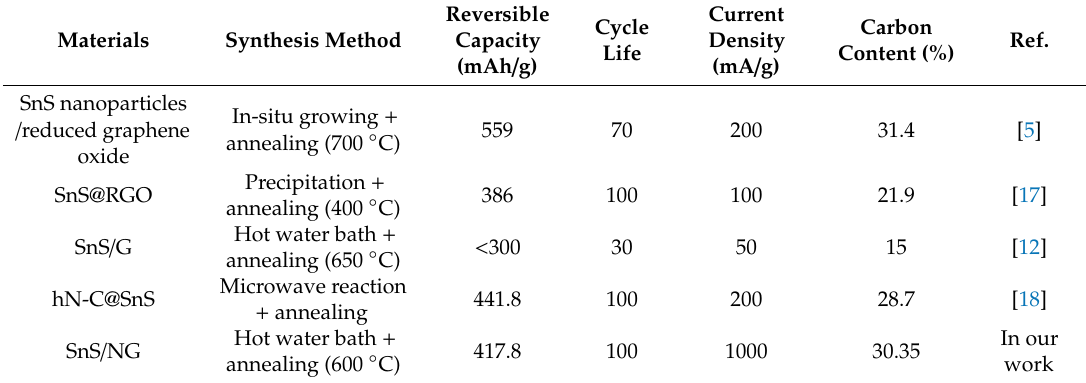
Table 1. Comparison of cycling performance of SnS / NG with previously reported Sn-based anodes for sodium ion batteries